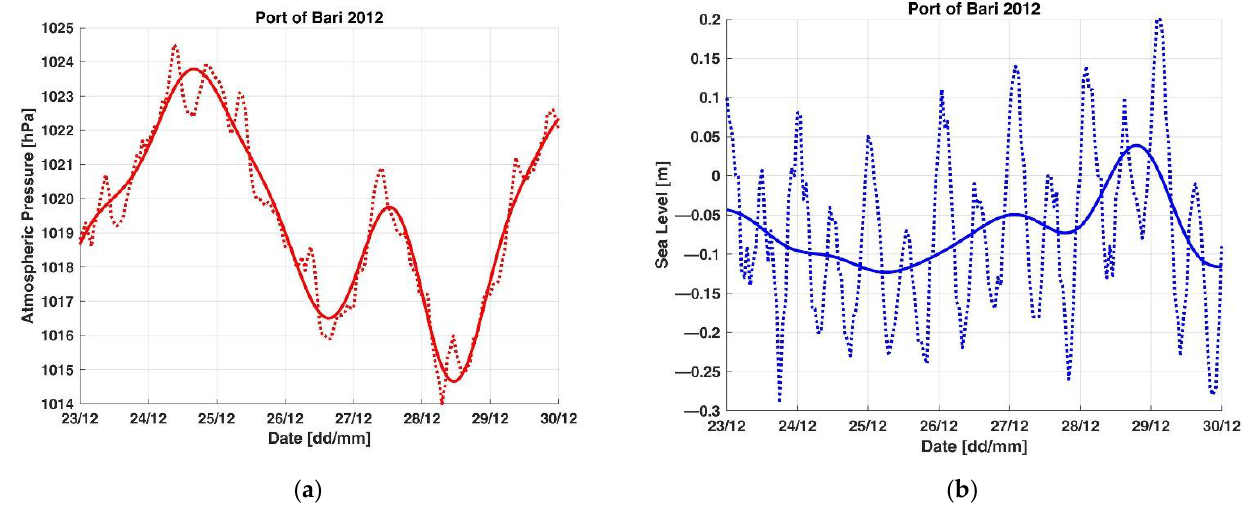
Figure A15. Low-frequency components of meteo-mareographic parameters acquired by ISPRA’s monitoring station in the port of Bari from 23 to 30 December 2012: ( a ) atmospheric pressure; ( b ) sea level.